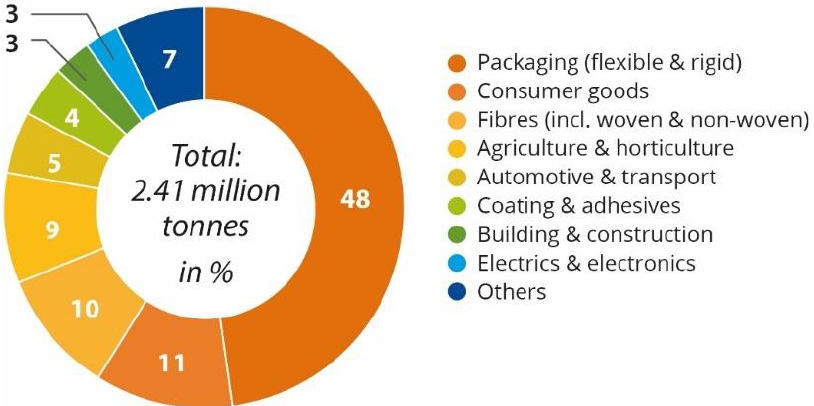
Figure 13. Global production capacities of bioplastics in 2021 (by market segment). Adapted from European Bioplastics “Global production capacities of bioplastics in 2021 (by market segment)”. https://www.european-bioplastics.org/wp-content/uploads/2021/11/Global_Prod_Market_Segment_circle_2021.jpg (accessed on 29 December 2022) [65].